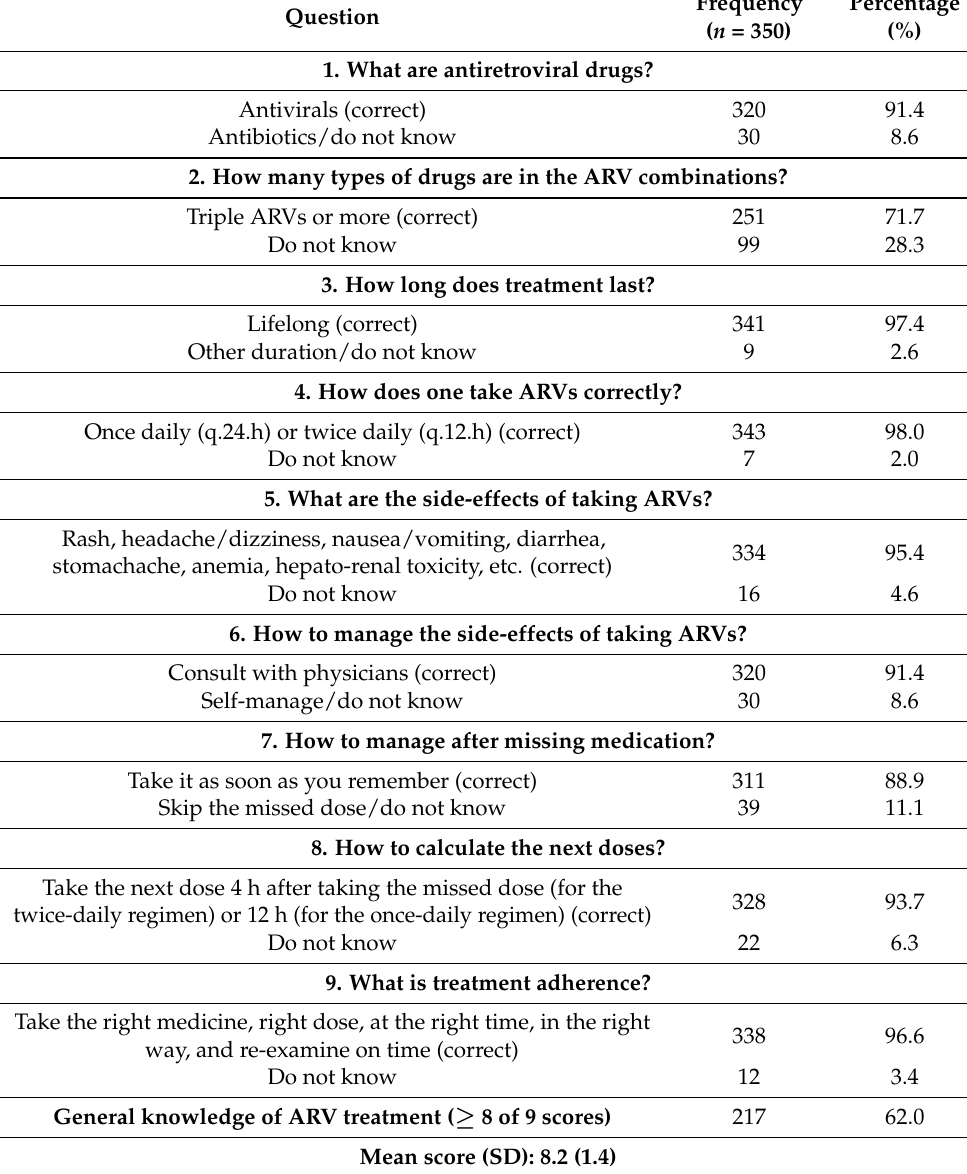
Table 2. Knowledge of ARV